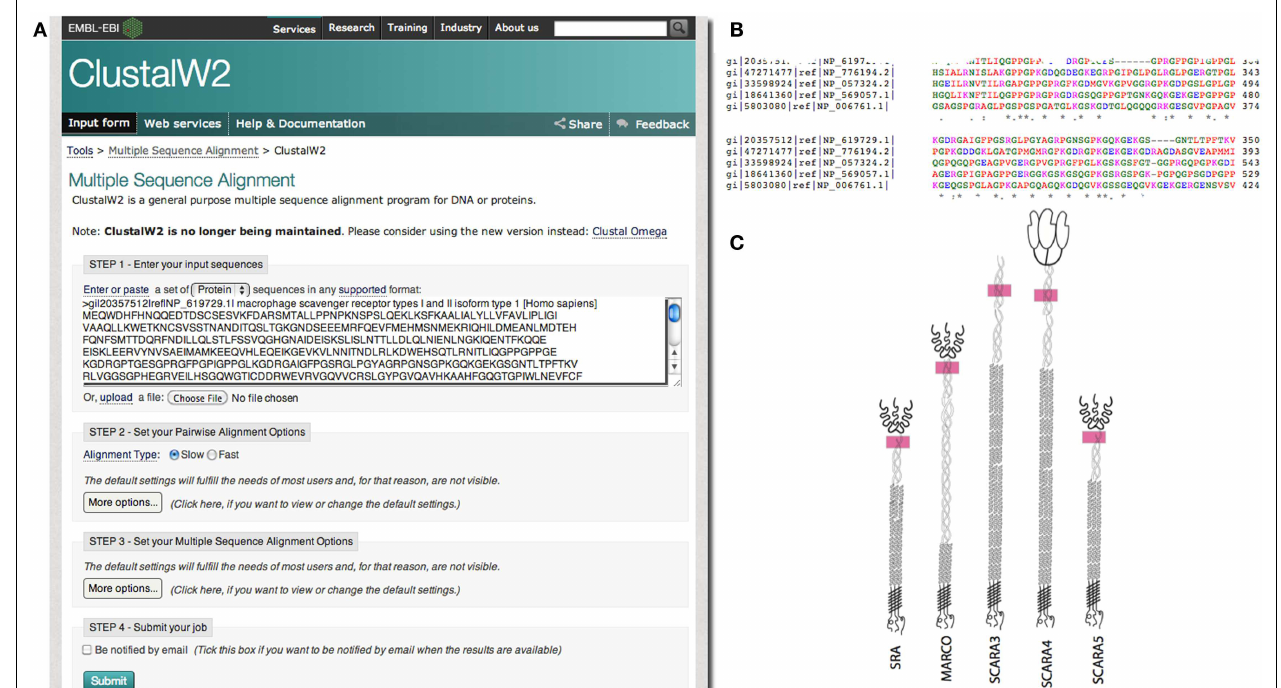
FIGURE 3 | Use of multiple sequence alignments to discover regions of evolutionary conservation and presumed functionality . FASTA formatted protein sequences of the scavenger receptors were obtained as described previously for SRAI (NP_619729.1), MARCO (NP_006761.1), SCARA3 (NP_057324.2), SCARA4 (NP_569057.1), and SCARA5 (NP_776194.2) and inputted into the Multiple Sequence Alignment tool, ClustalW2 (A) .The sequences were aligned; a portion of the alignment with the highest conservation across all five sequences is shown (B) .The user may choose to view colored output, where red represents small, hydrophobic amino acids (AVFPMILW), blue represents acidic amino acids (DE), magenta represents basic amino acids (RK), and green represents STYHCNGQ (hydroxyl,